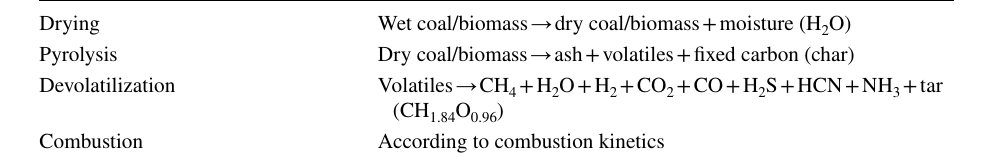
According to combustion kinetics